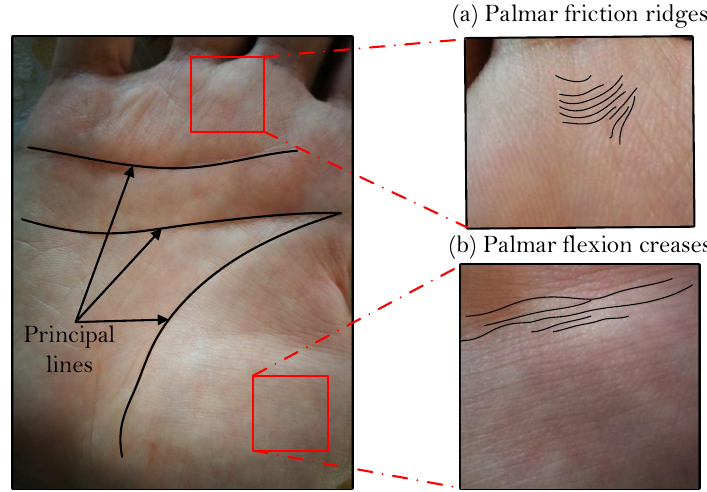
Figure 1. Illustration of the main palmprint characteristics/features commonly used for identity inference in palmprint recognition systems: ( a ) palmar friction ridges and ( b ) palmar flexion